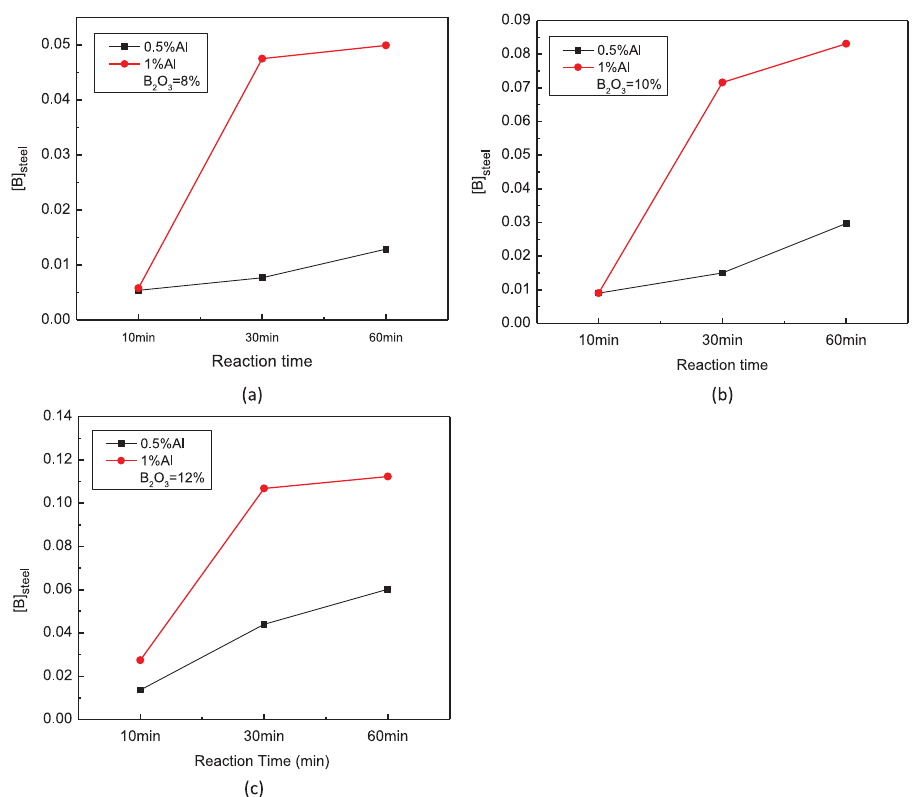
Figure 6: The change of [B] content of high Al steel with different content of [Al] in